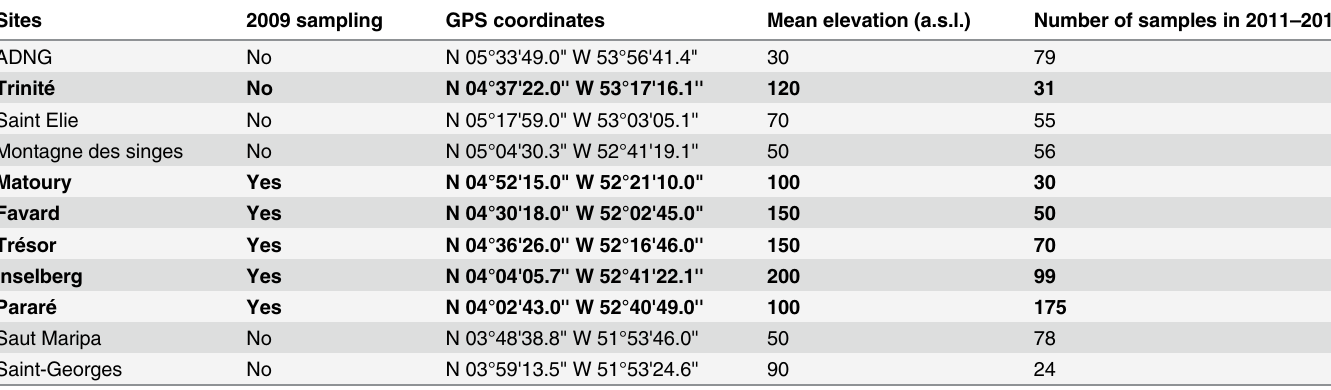
Table 1. Location of the11 sampled sites, locality, and mean elevation.